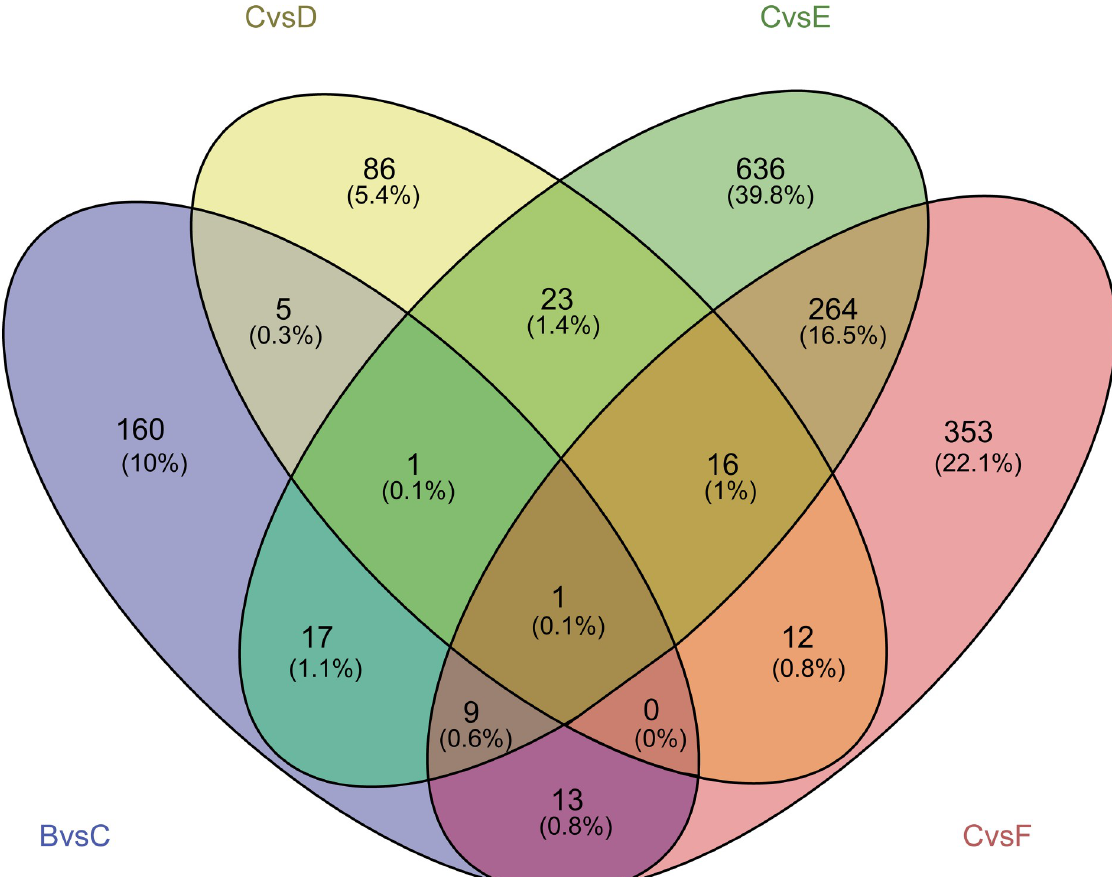
Fig 2. Differentially expressed genes in SHENQI compound group (blue), yangyinyiqi group (yellow), huoxue group (green) and rosiglitazone group (red).